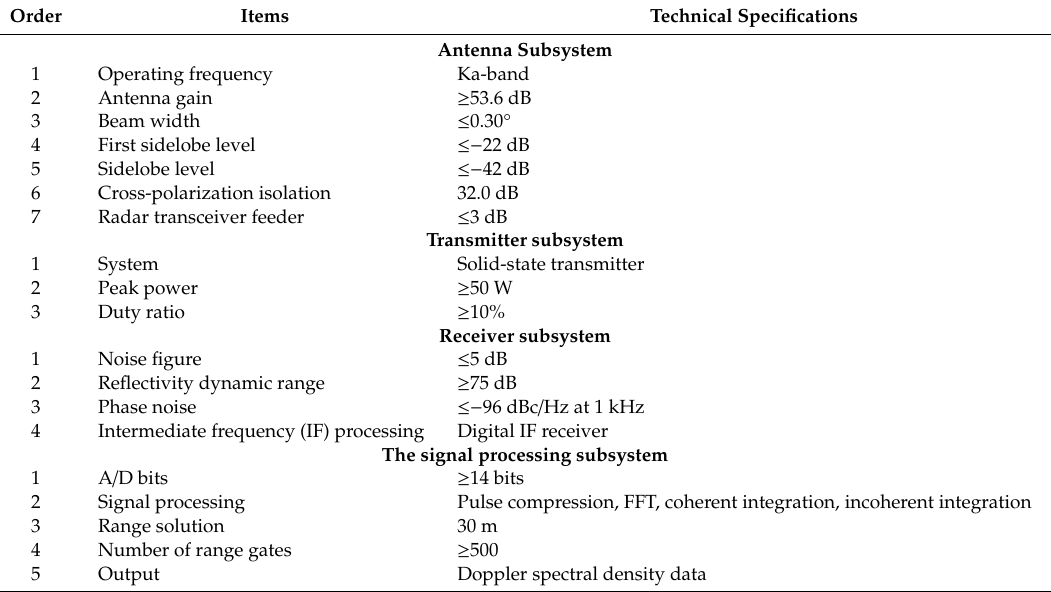
Table 2. Cloud radar subsystem